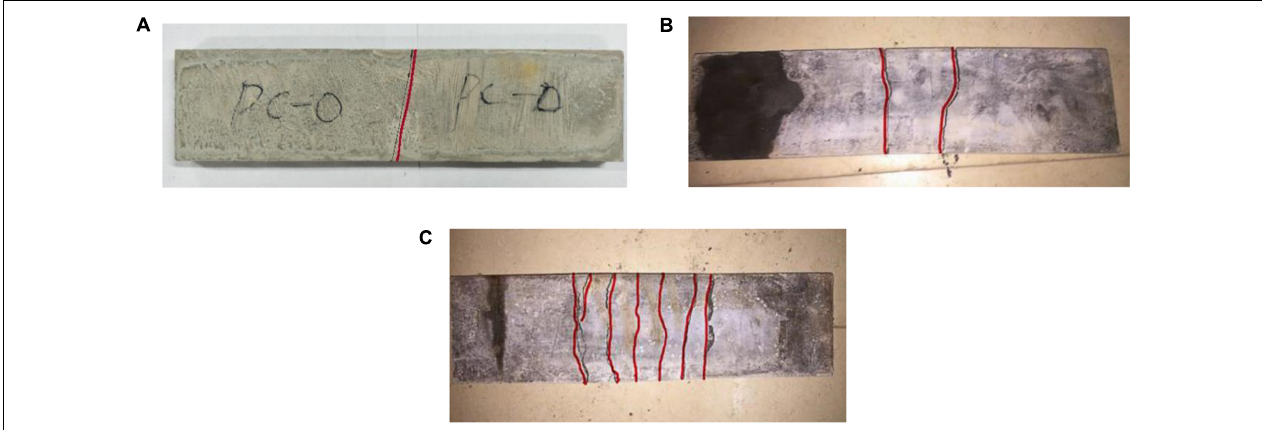
FIGURE 4 | Sheet failure modes. (A) PC sheet. (B) BTRC sheet without short fibers. (C) BTRC sheet with short fibers.